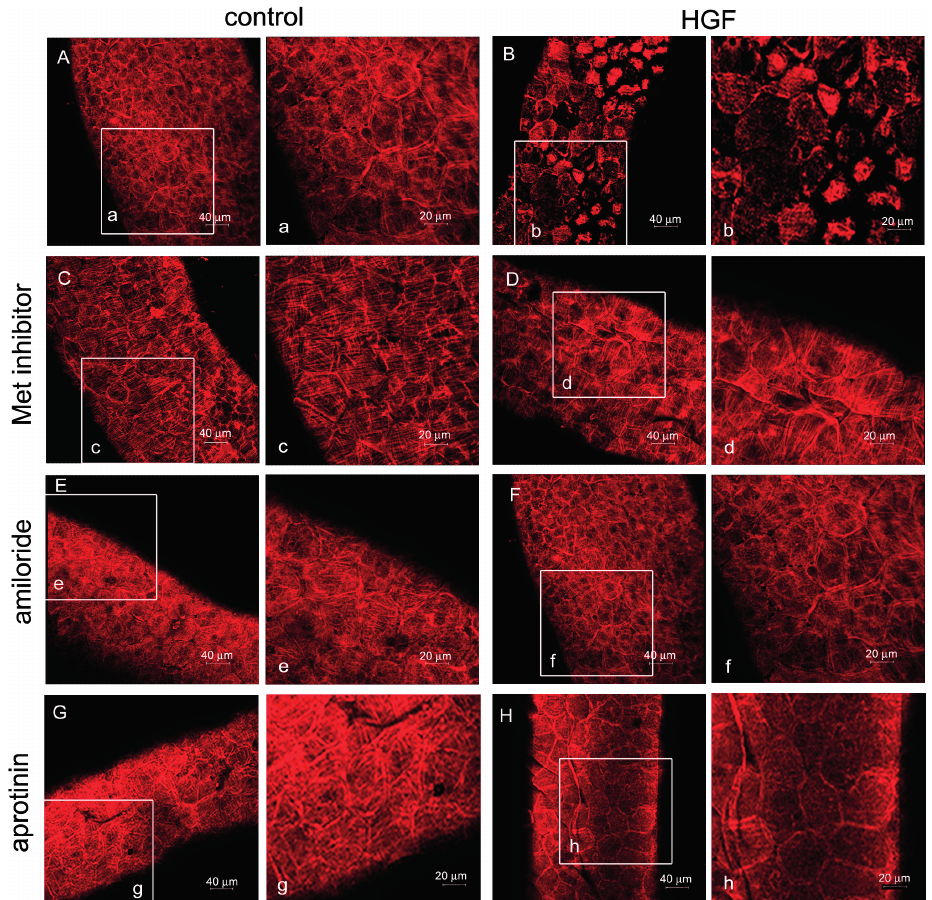
Figure 4. Confocal analysis of F-actin cytoskeletal modifications in cultured adult rat seminiferous tubules isolated at Stages VI–VIII. The figure shows the F-actin cytoskeletal pattern of adult rat seminiferous tubules (Stages VI–VIII) cultured for 24 h in